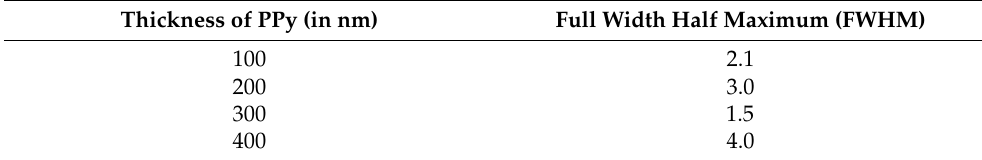
Table 2. Values of FWHM with thickness of PPy thin film. Thickness of PPy (in